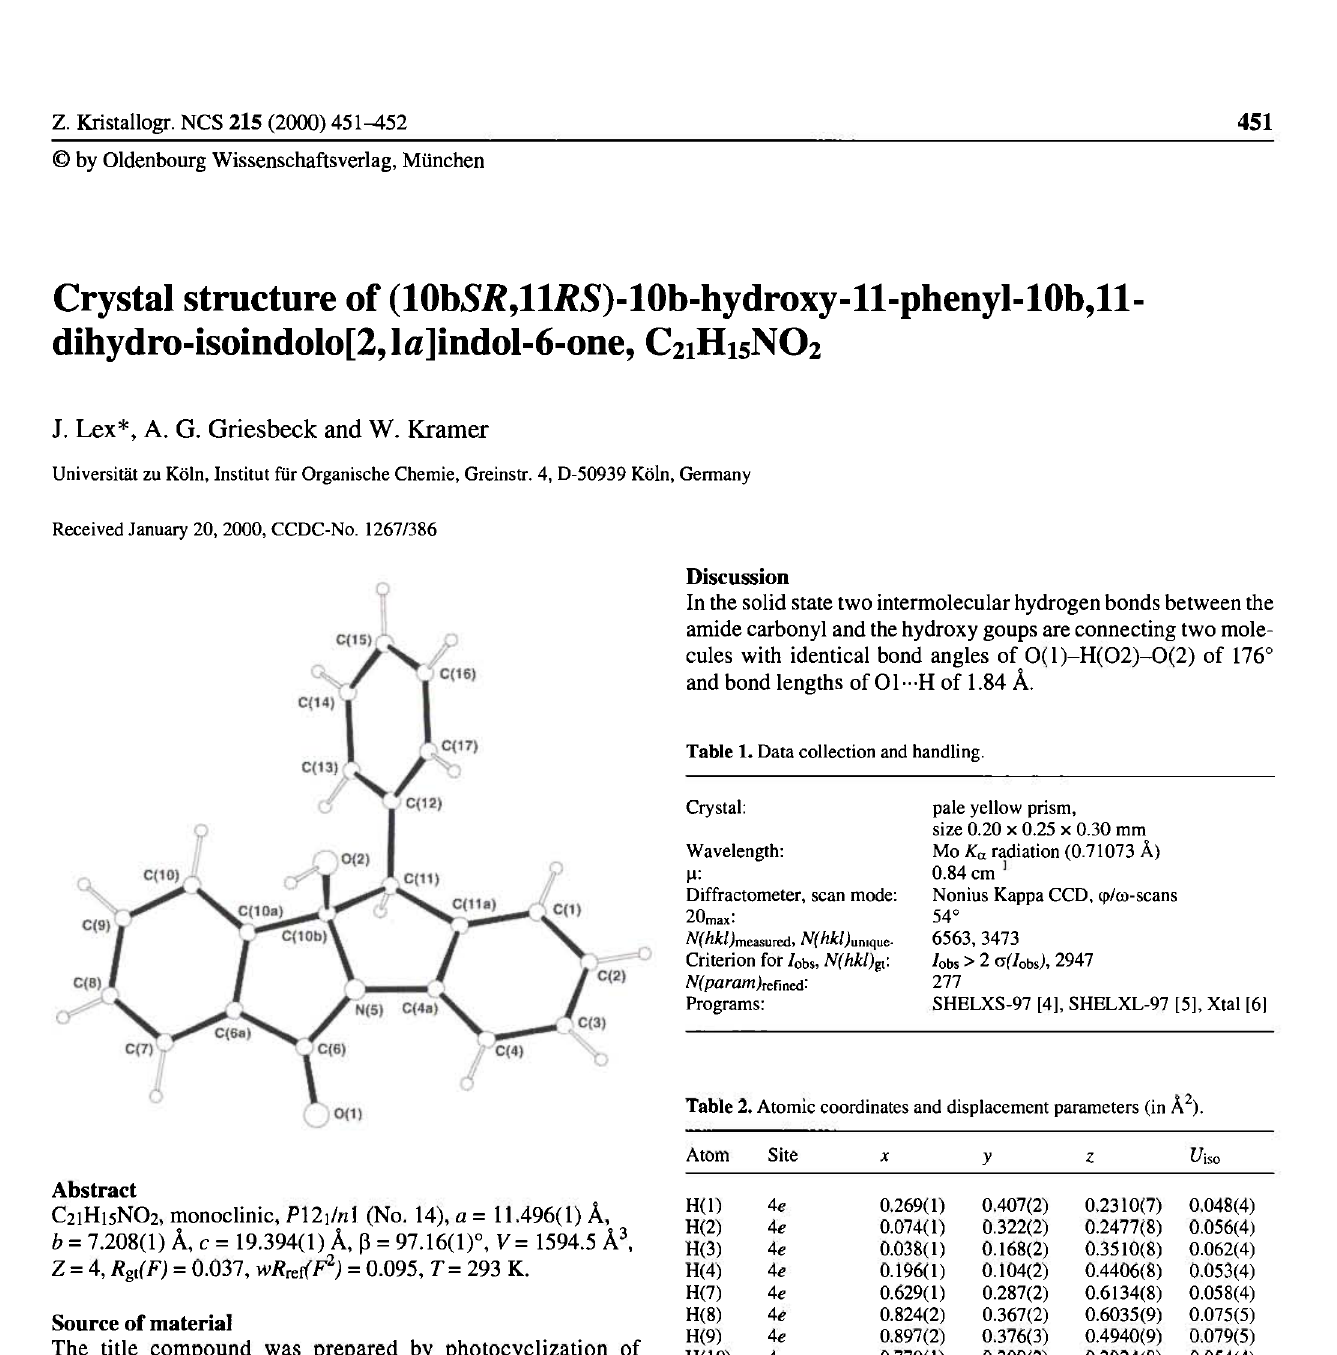
Table 2. Atomic coordinates and displacement parameters (in λ 2 ).